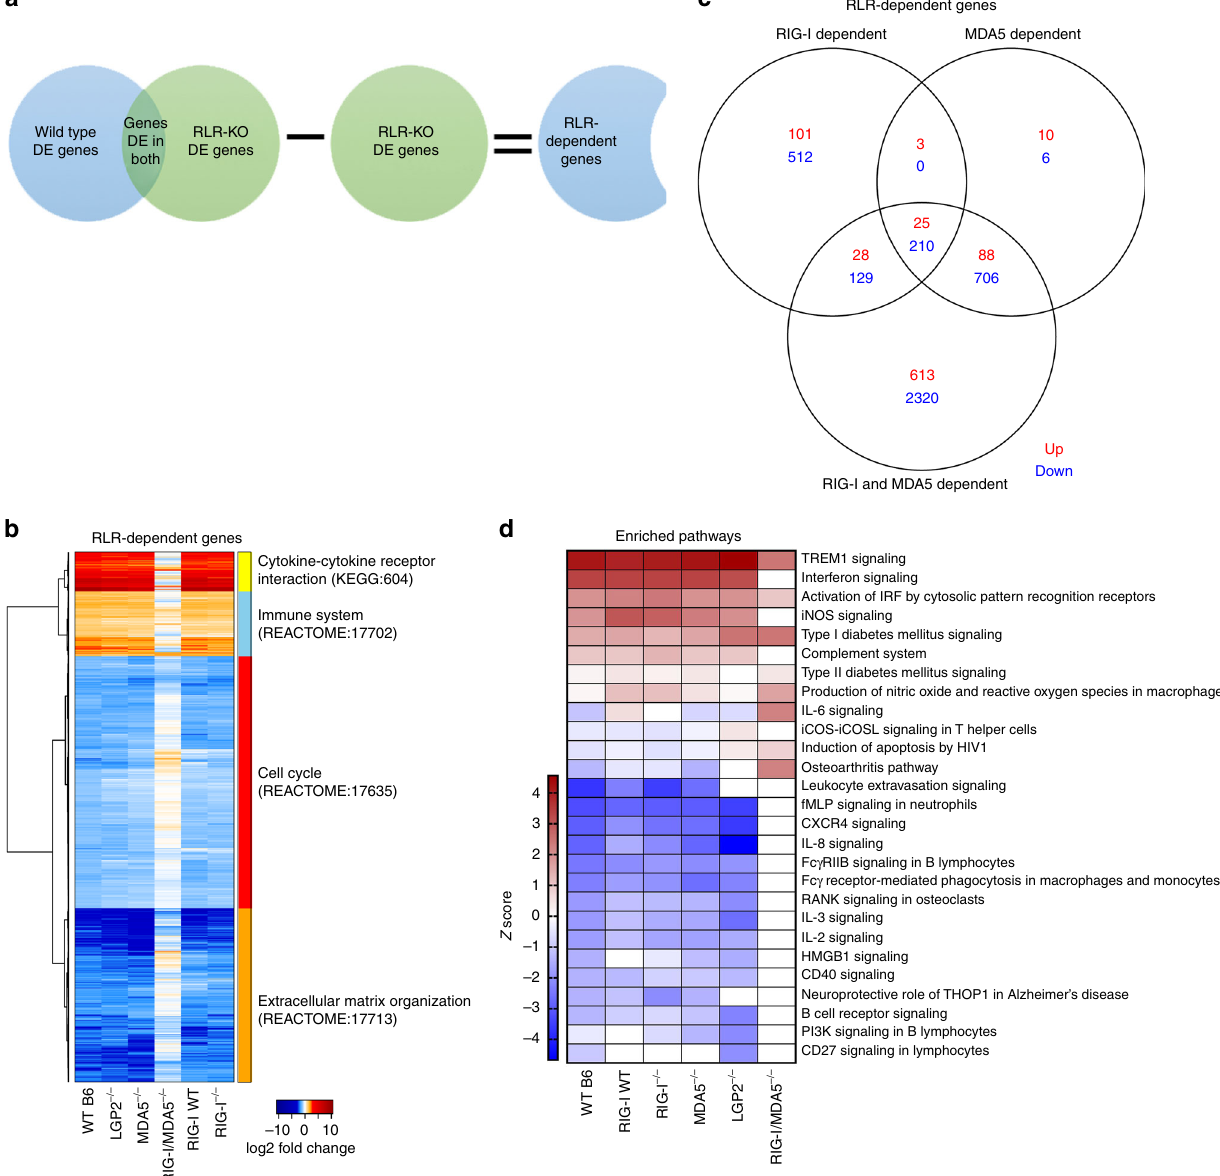
Fig. 3 RIG-I and MDA5-dependent genes. a Schematic of how RLR-dependent genes were determined. b Genes that were determined to be dependent on RIG-I and MDA5 (DKO) are shown by heatmap for the 24h time point. Heatmap is set up the same as in Fig. 2b. c Venn diagram of the number of genes missing from DKO, RIG-I − / − , and MDA5 − / − sequencing results compared to the WT response. d Pathway analysis (Z-scores) of each RLR-KO DE gene list are shown by heatmap. Red shows pathways that activated while blue shows pathways that are inhibited. Pathways are named on the right. n = 3 (DKO), 4 (LGP2 − / − , MDA5 − / − , RIG-I WT, RIG-I − / − ), or 5 (WT B6) independent infections, RNA preparations, and sequencing results. Source data are provided as a Source Data fi